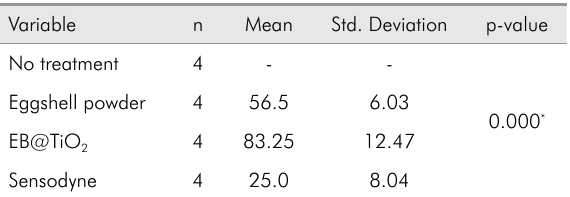
Table 1. ANOVA test for the occluded dentine tubules after treatment.